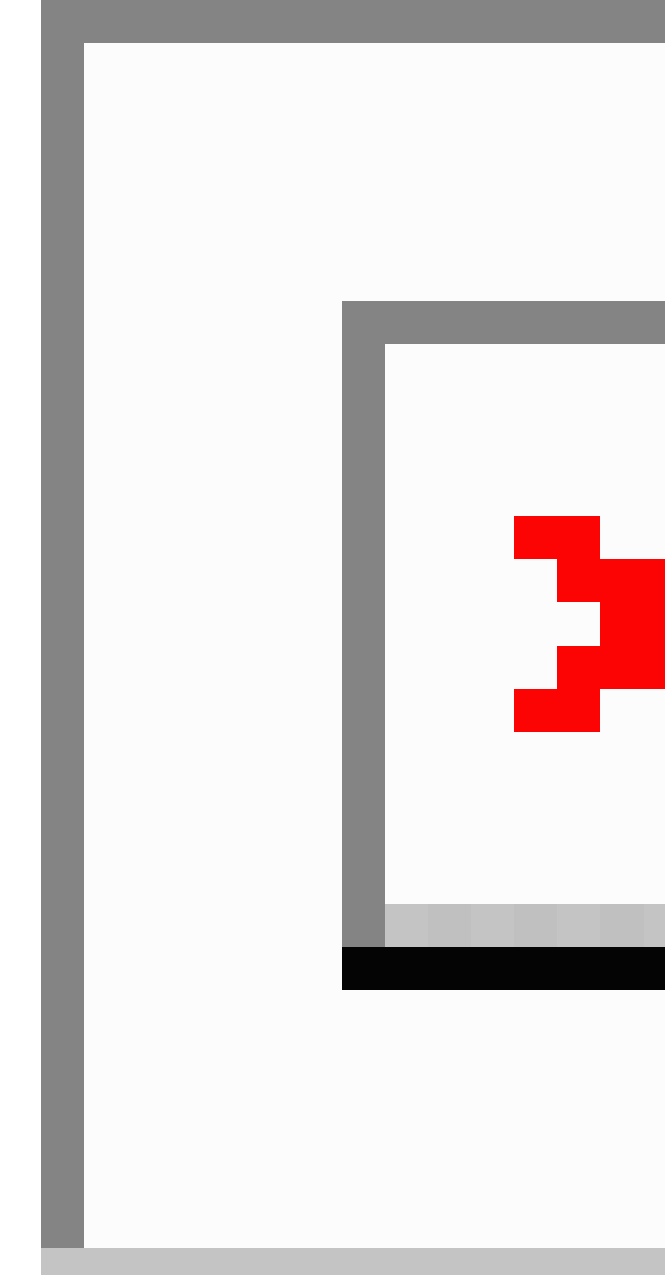
Figure 5. HealthTrust calculation for diabetes videos from